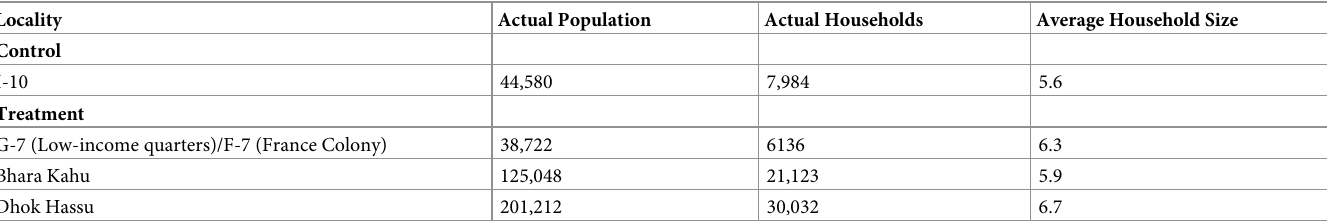
Table 1. Location characteristics of study